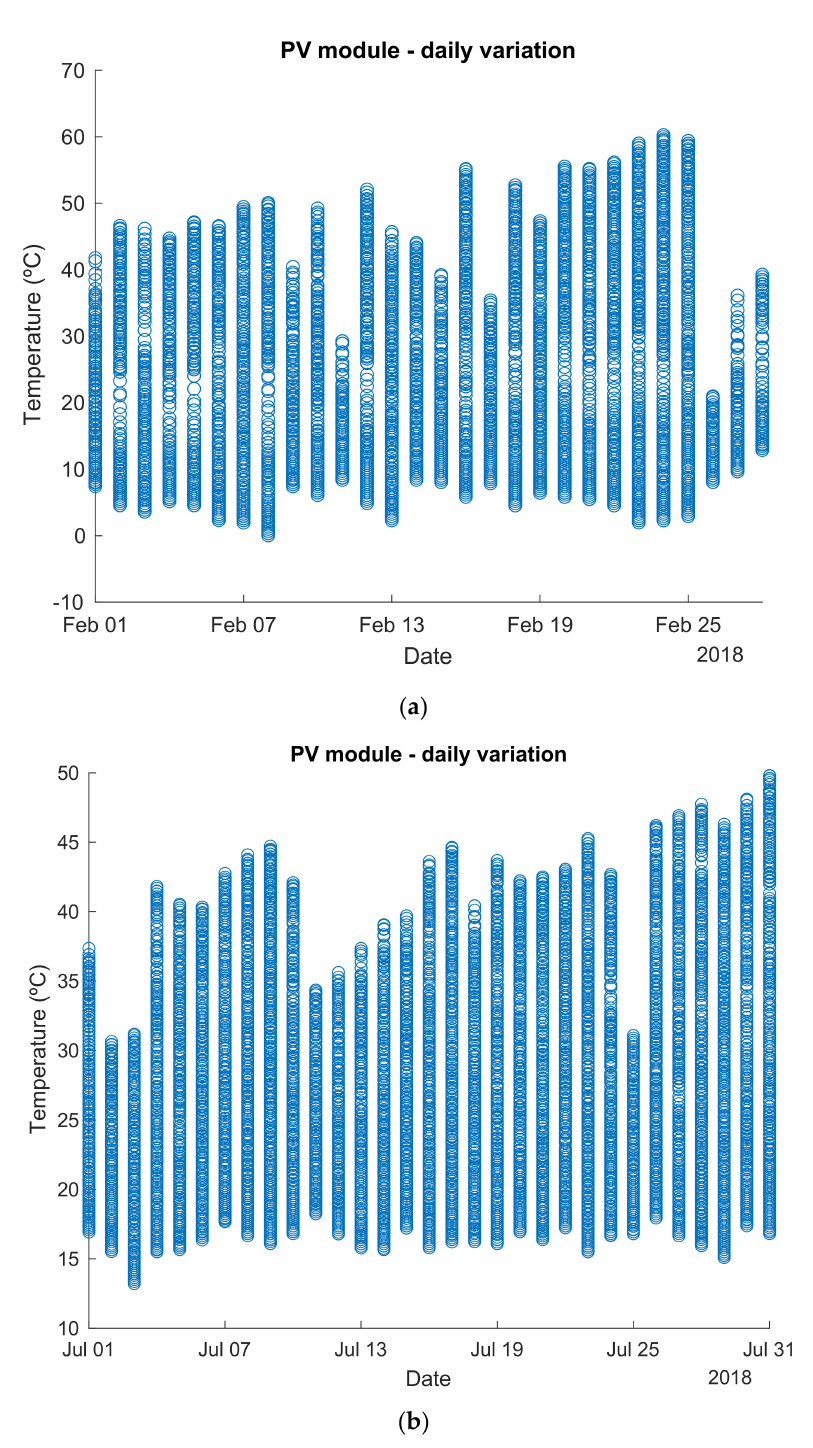
Figure A5. Detailed PV module temperature daily variation: ( a ) February/2018; ( b )